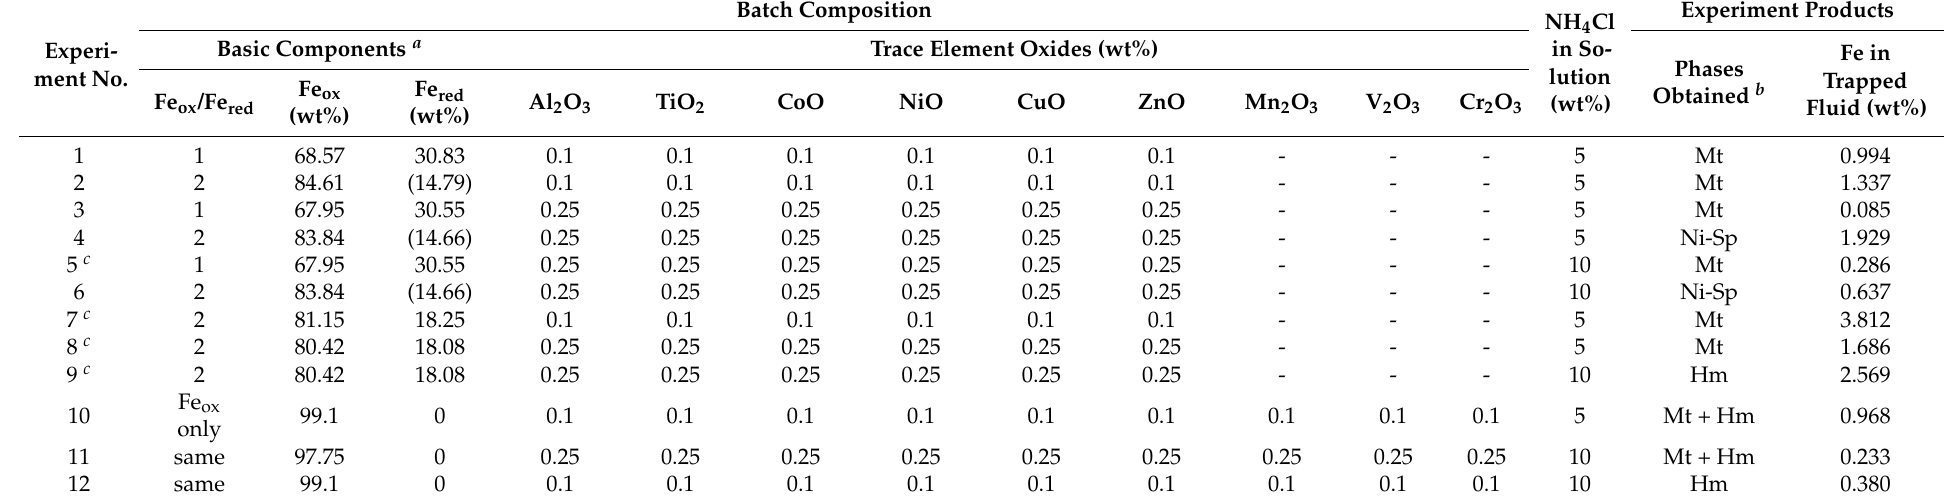
Batch Composition